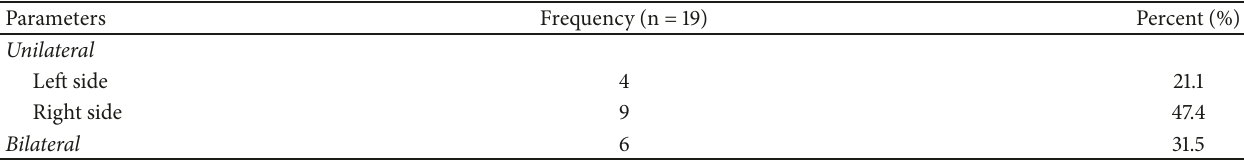
Table 2: Laterality of procedure on